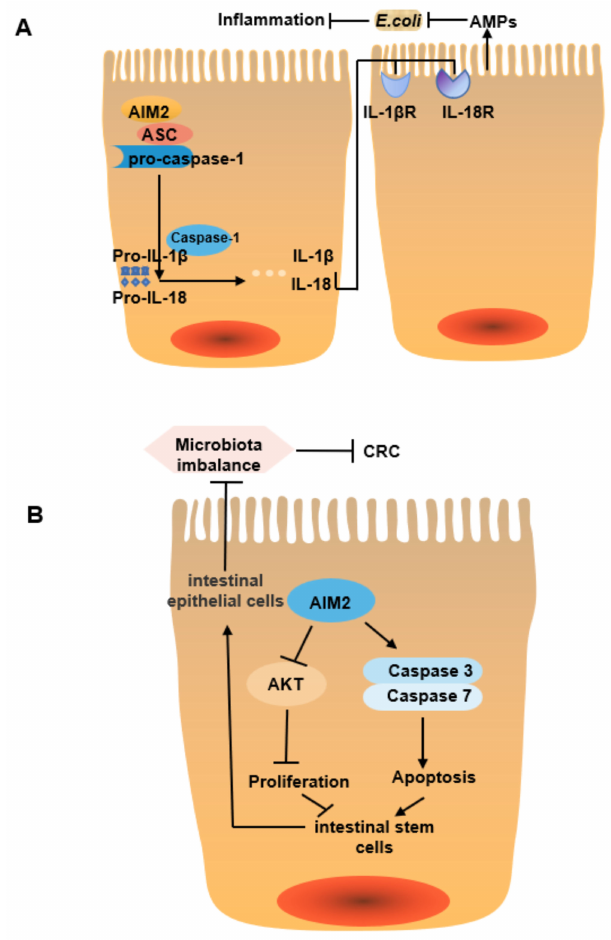
Figure 2. The pathway for Aim2 mediated regulation of microbiota. ( A ) Aim2 in intestinal epithelial cells (IECs) is activated by microbiota dsDNA in the cytoplasm and assembles the inflammasome by recruiting ASC and pro-caspase-1. The Aim2 inflammasome activates caspase-1 and induces the maturation of IL-1 β and IL-18, which bind to their respective receptors IL-1 β R and IL-18R on epithelial and immune cells, thereby increasing the production of AMPs to inhibit E. coli and reducing host susceptibility to colitis. ( B ) Aim2 can inhibit AKT and activate caspase3/7 signaling pathway to regulate cell proliferation and apoptosis, thus preventing intestinal stem cells from overproliferating and thus differentiating to form mature intestinal epithelial cells, thereby inhibiting gut microbiota translocation disorder and